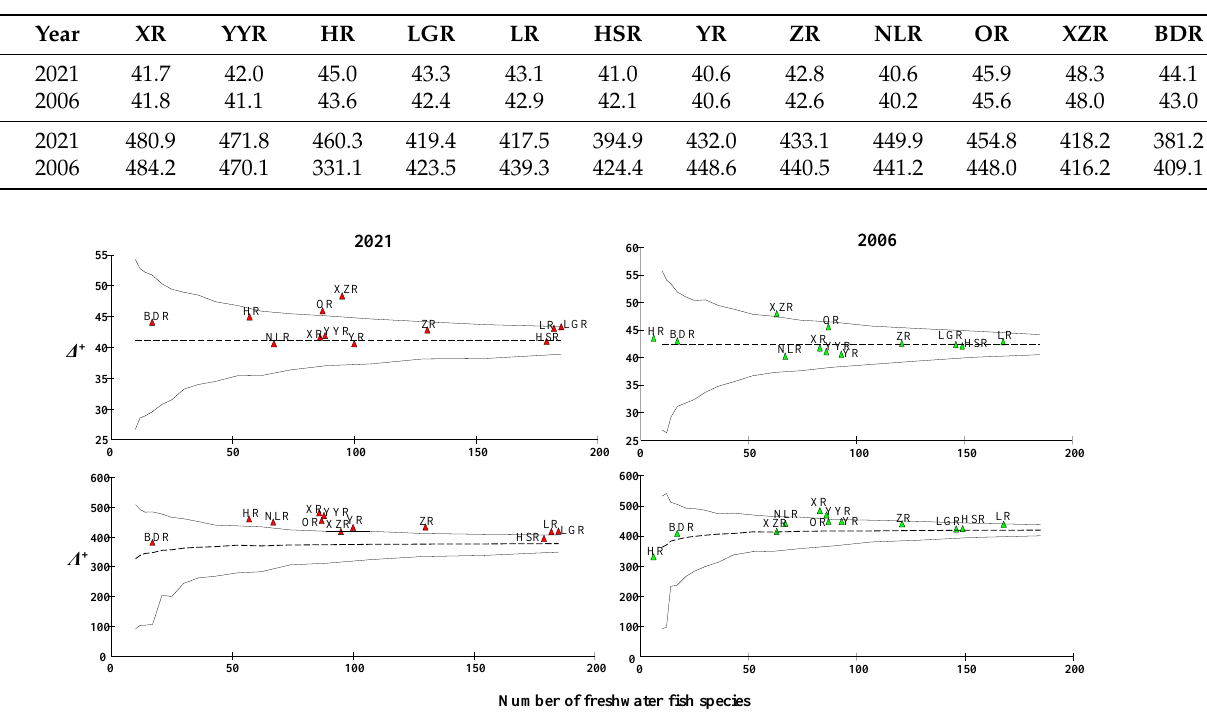
Figure 4. Comparison between 2006 and 2021 at the G , F , and G-F indices of 12 Sub−basin s in Guangxi. GX stands for the whole basins of Guangxi; Sub−basin codes are described in Table 1.